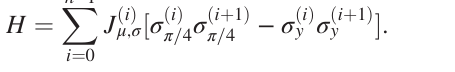
FIG. 5. For different values of m , the intervals ½ ϵ we detect that the ground state of Eq. (64) is nonlocal. Observe that, for m ¼ 2 , which corresponds to the case where the chained Bell inequality is the CHSH Bell inequality, we detect nonlocality in the largest parameter region (cf. Fig. 4). For ϵ ¼ 1 , non- locality is always detected, since ð m − 1 Þ > 1 for all m > 1 , as it is shown in Eq.